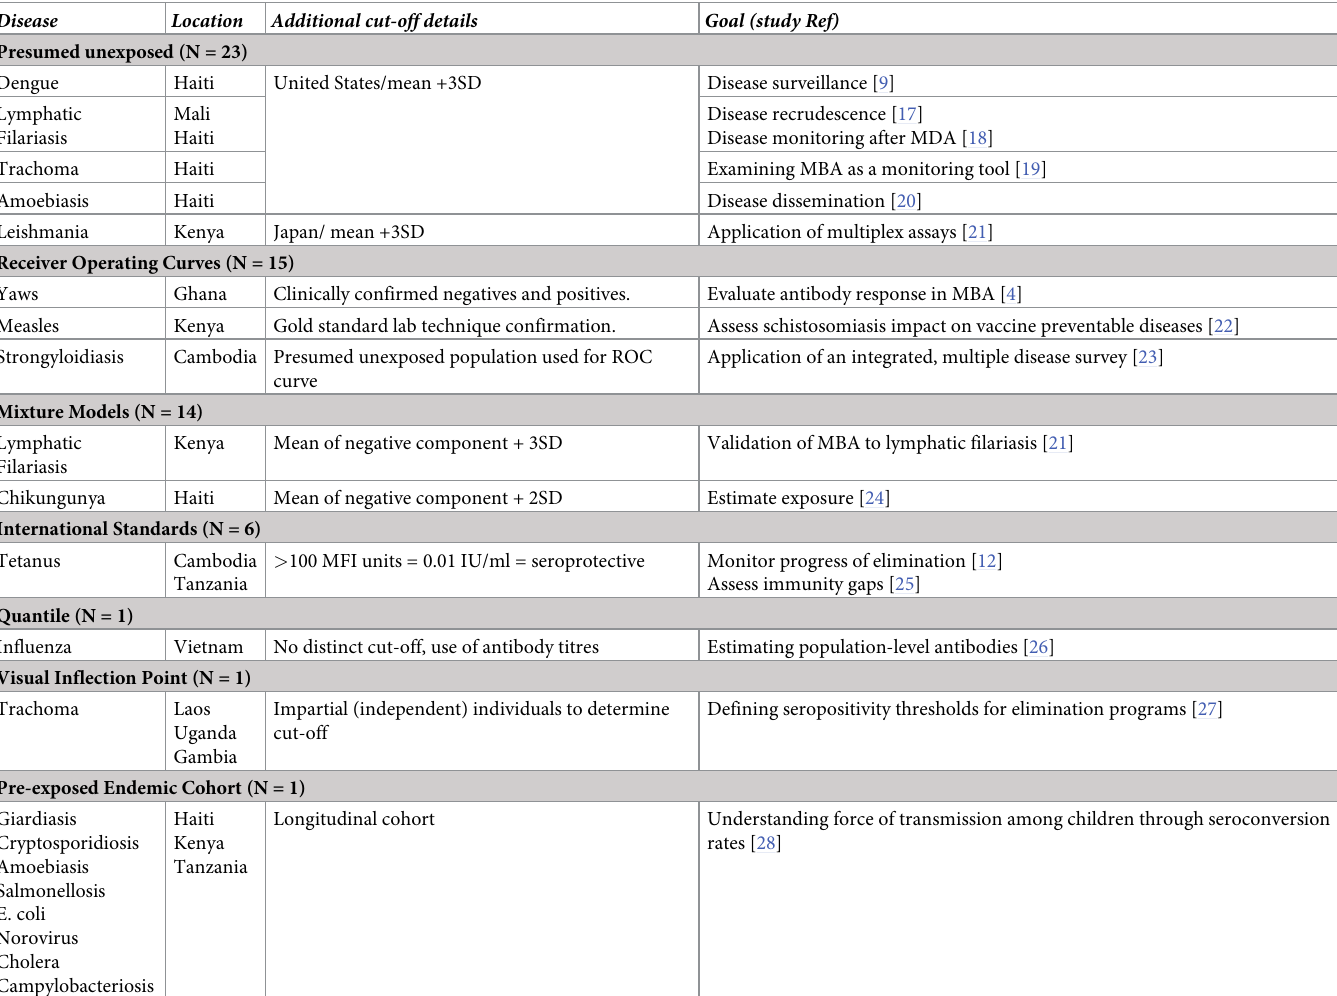
Table 1. Examples of several applied cut-off approaches using MBAs in various settings for NTDs and VPDs. MBA used, location, cut-off approach, and the goal of the program are provided in this table to demonstrate the application of cut-off methods in different settings. Where, N refers to the number of studies employing the method and SD refers to standard